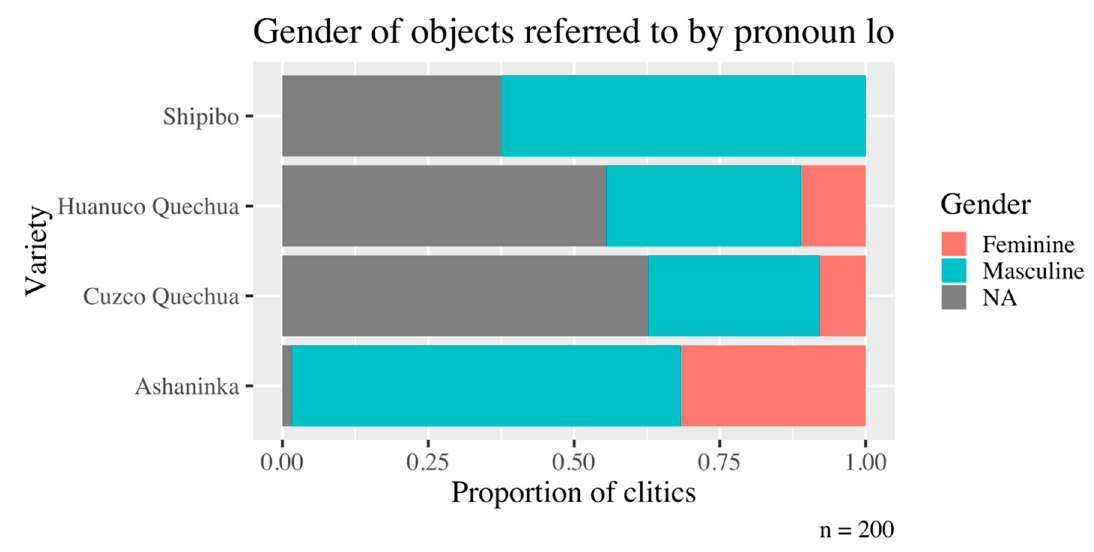
Languages 2019 , 4 , x FOR PEER REVIEW Figure 11. Gender of objects referred to by pronoun lo. Figure 11. Gender of objects referred to by pronoun lo.